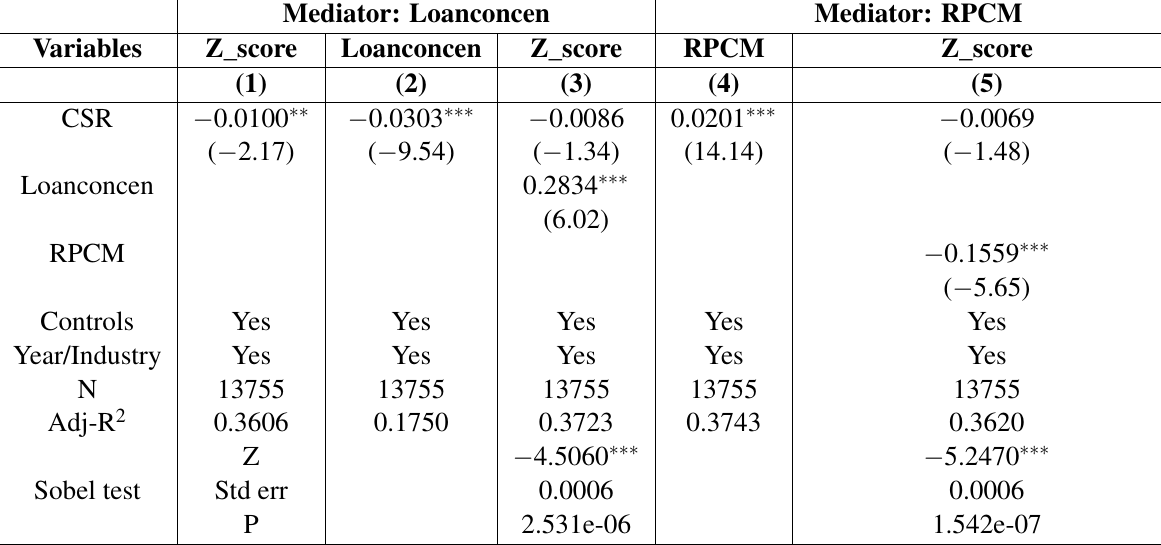
Table 9 Sample of firms registered in the eastern